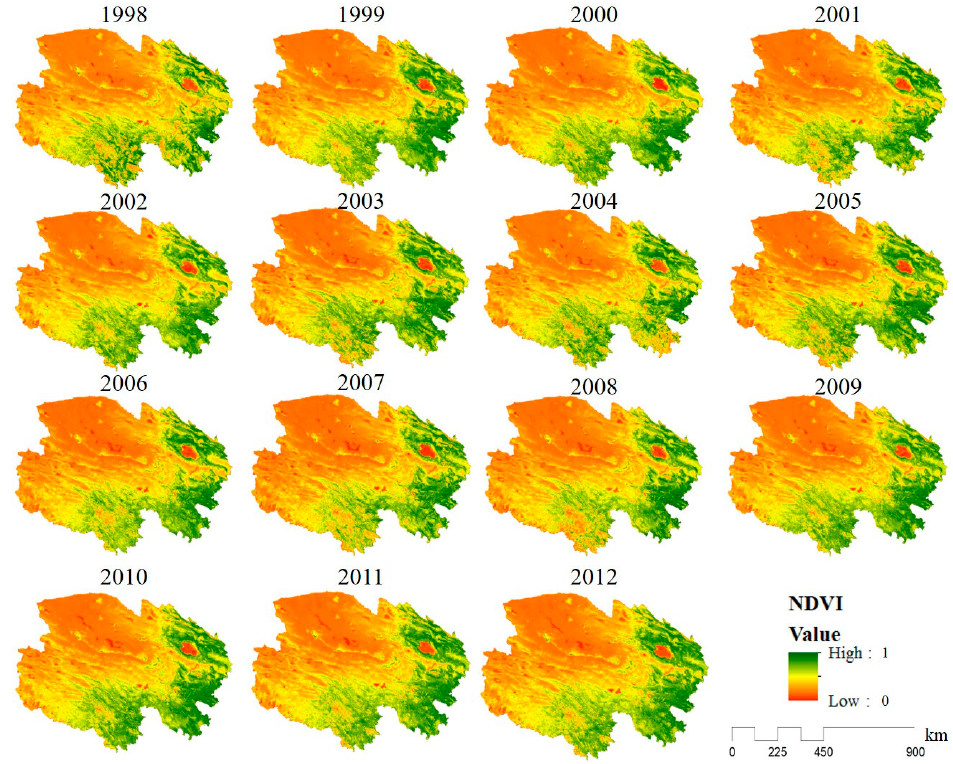
Figure 5. The temporal change and spatial distribution of Normal Difference Vegetation Index (NDVI) from 2000 to 2012 in Qinghai Province.